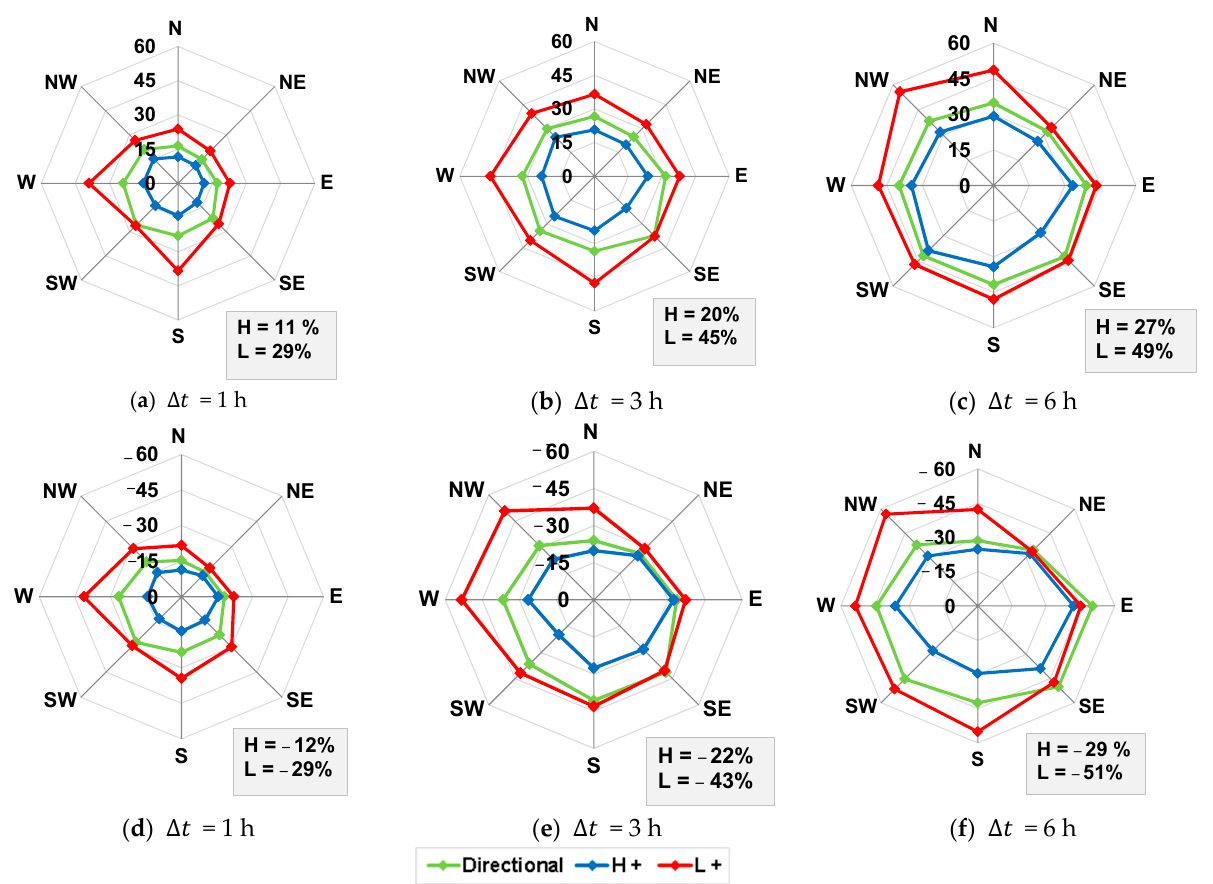
Figure 12. ( a – c ) Upward and ( d – f ) downward wind power ramps for the different weather regimes and time intervals— ∆ t (1, 3, and 6 h).